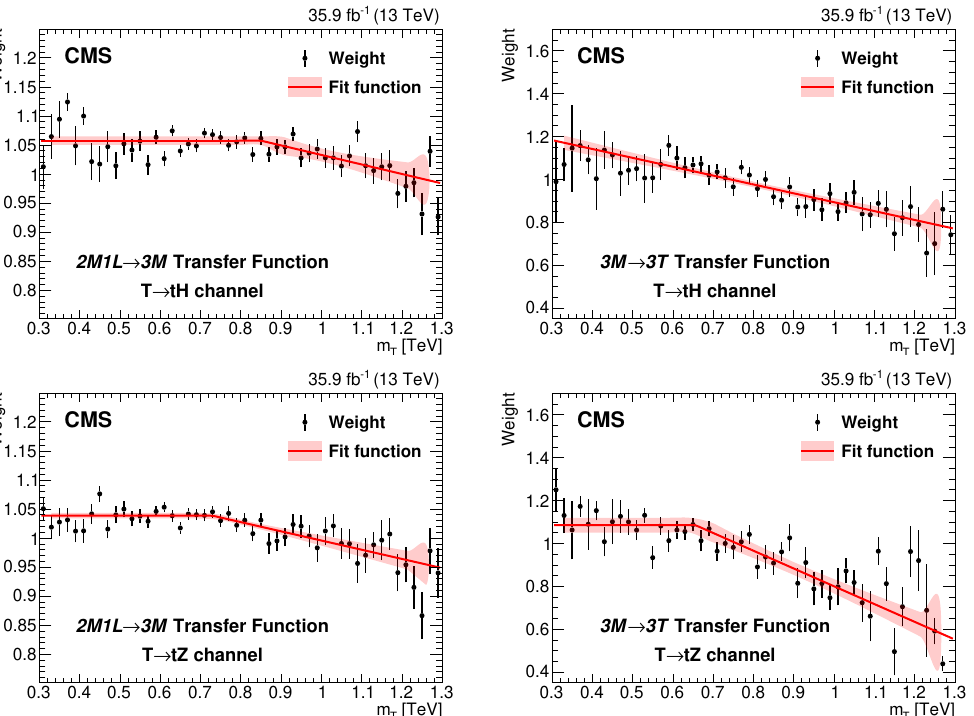
Figure 3 . Dependence of the reweighting values (product of all b tagging weights) on the (cid:12)ve-jet invariant mass for the 2 M 1 L region (left) and for the 3 M region (right), in the case of the tH channel (upper) and the tZ channel (lower). These variations are (cid:12)tted to obtain the transfer functions (in red) using either a 3-parameter function with a constant term and a slope, or a 2- parameter straight line. The light red shaded regions represent the central 68% CL interval for each (cid:12)t when taking into account only the statistical